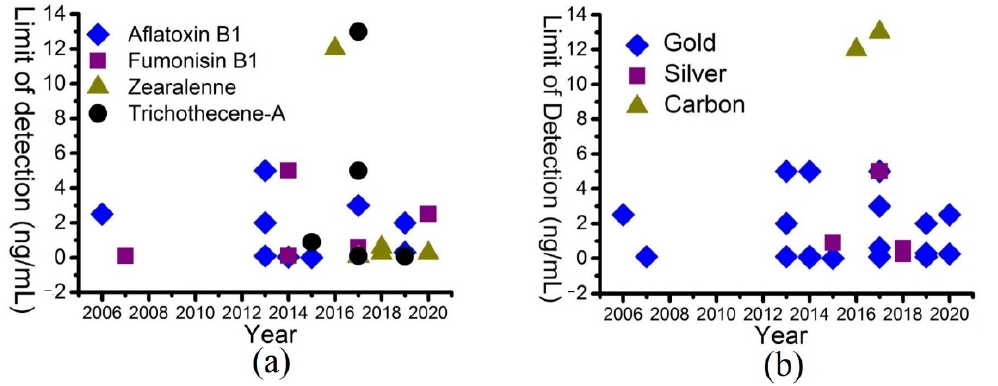
Figure 3. Timeline of limit of detection on mycotoxins and materials of nanoparticles. ( a ) Different mycotoxins (Blue diamond: Aflatoxin B1; Purple square: Fumonisin B1; Green triangle: Zearalenone; Black circle: Trichothecene–A); ( b ) Different materials of nanoparticles (Blue diamond: Gold; Purple square: Silver; Green triangle: Carbon).